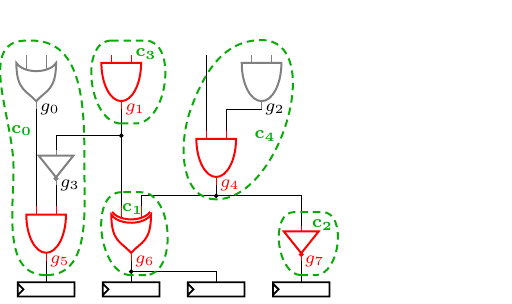
Figure 3: Clustering gates of a given digital logic circuit to reduce the verification complexity.